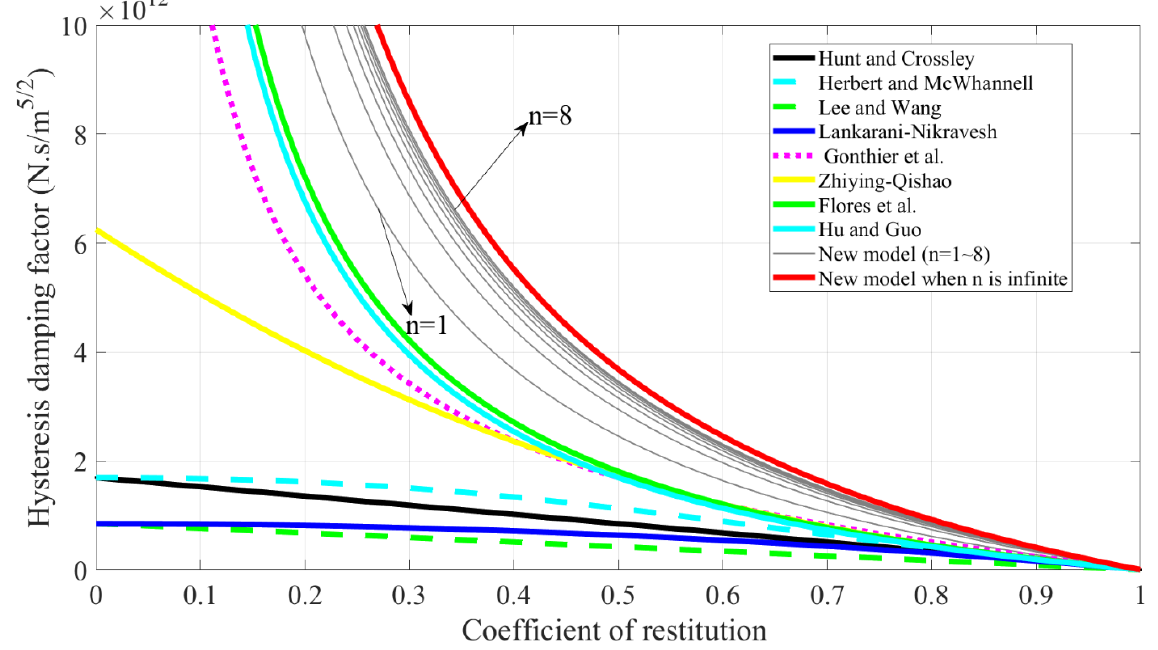
Figure 5. Comparison analysis of hysteresis damping factors.